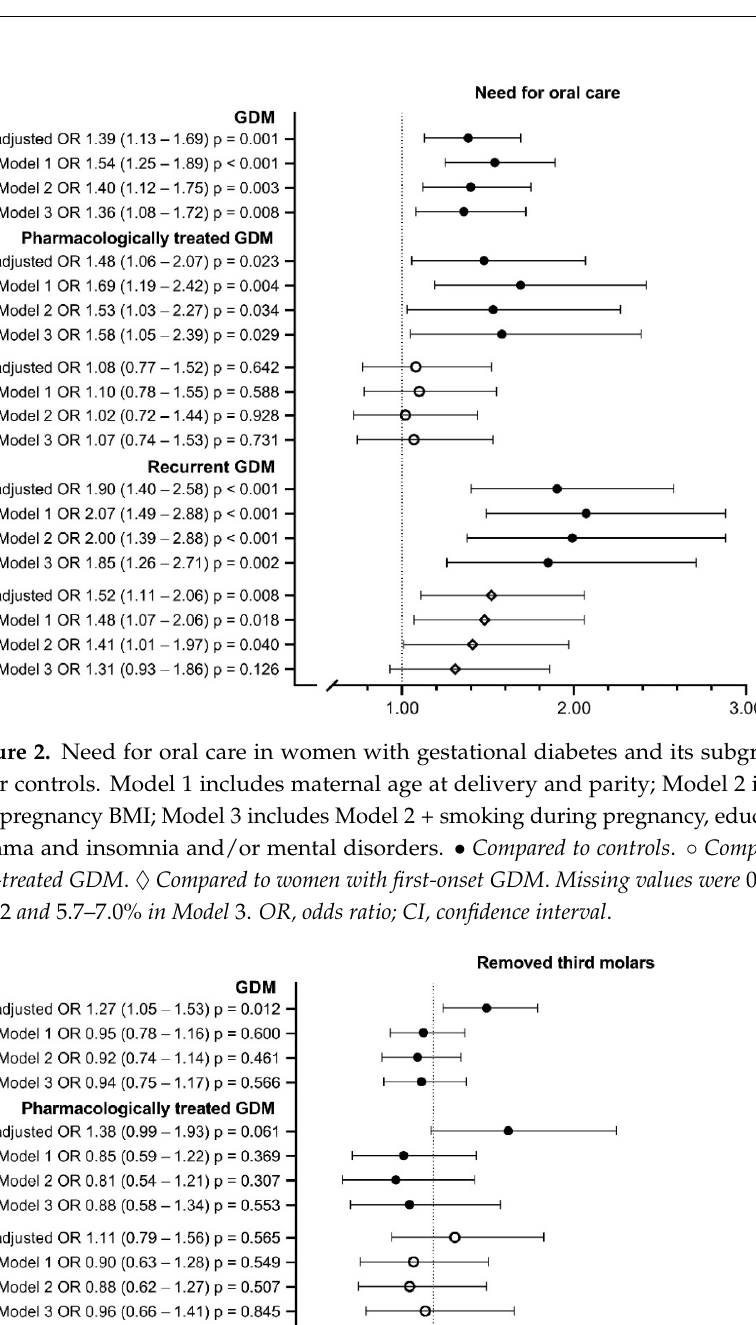
Figure 4. Third molar symptoms in women with gestational diabetes and its subgroups. Model 1 includes maternal age at birth and parity; model 2 includes model 1 + pre-pregnancy BMI; model 3